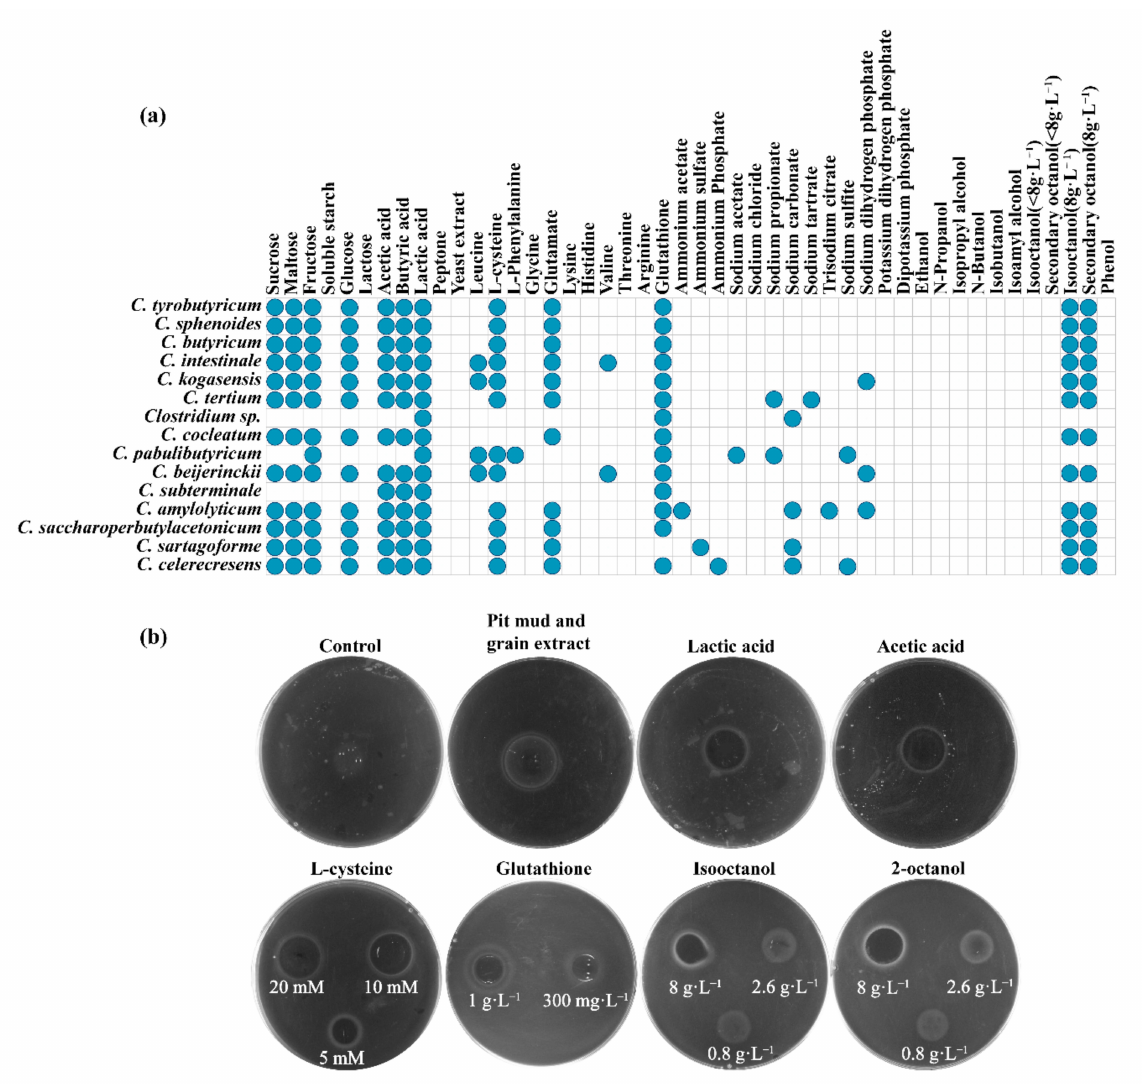
Figure 3. Analysis of chemotaxis of Clostridium strains to chemical factors: ( a ) chemotaxis of Clostrid- ium strains to different substances; ( b ) chemotaxis of Clostridium detected by the agar disc method. Lactic acid bacteria (LAB), yeast and Bacillus are critical and functional microorganisms for strong-flavor Baijiu production. Growth and metabolism of Clostridium during strong- flavor Baijiu fermentation can be affected by these microorganisms. In this work, chemotaxis of Clostridium to LAB, yeast and Bacillus strains (isolated from pit mud or fermented grains of strong-flavor Baijiu) were investigated. It showed that none of the Clostridium had chemotaxis to the tested Bacillus or yeast strains (Figure 4a). However, all of them had chemotaxis to the tested LAB (Figure